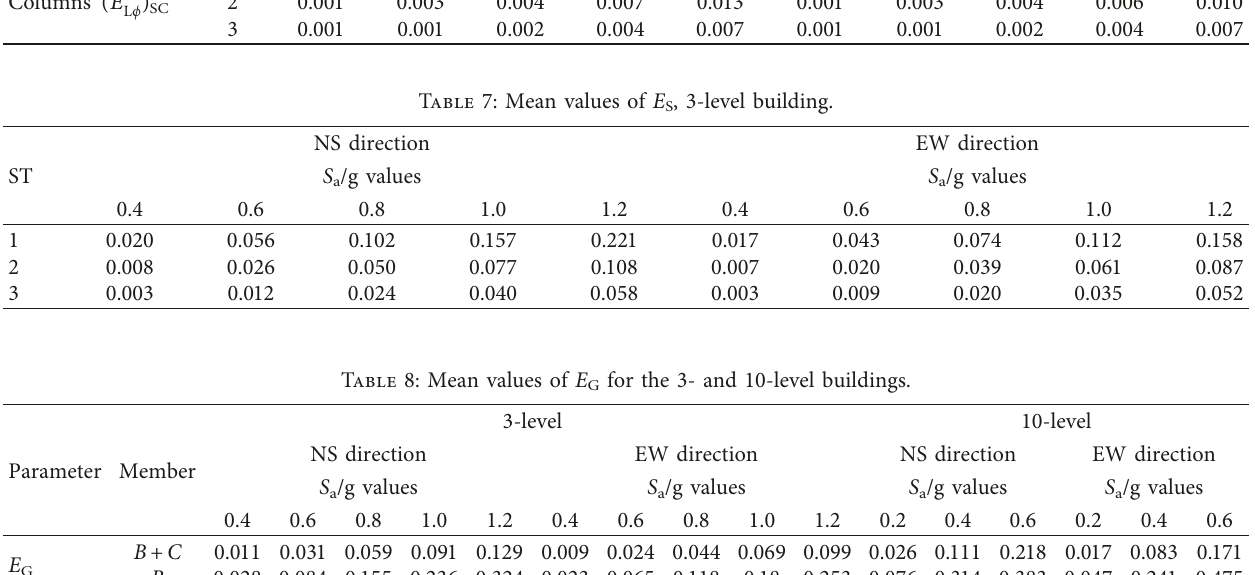
S , 3-level building.